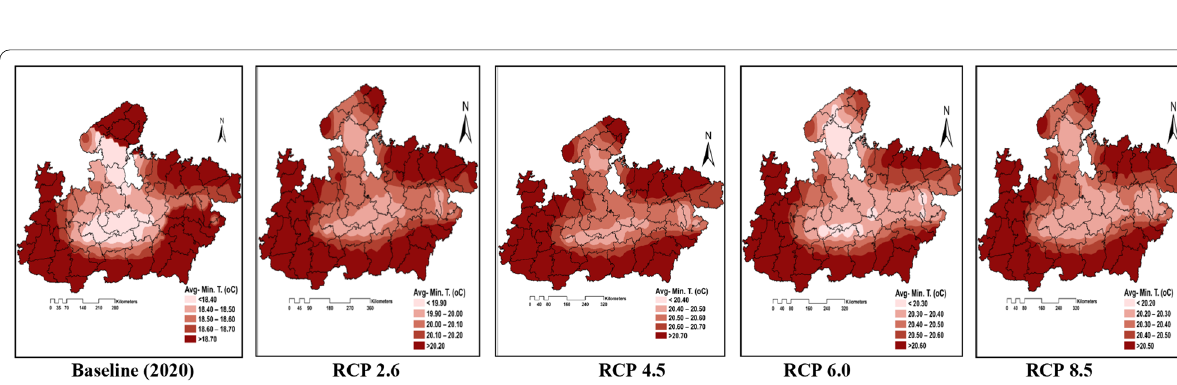
Fig. 9 Predicted change in the minimum temperature relative to baseline over the whole Madhya Pradesh state under different RCP scenarios of 2050. Under all the RCP scenarios, the average minimum temperature is projected to